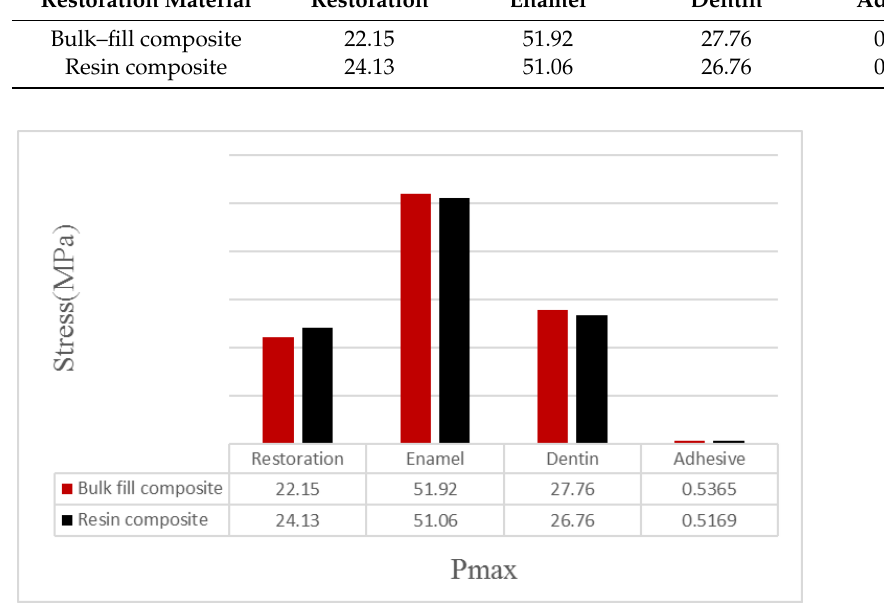
Figure 5. Stress distributions in tooth components restored as a result of occlusal forces.